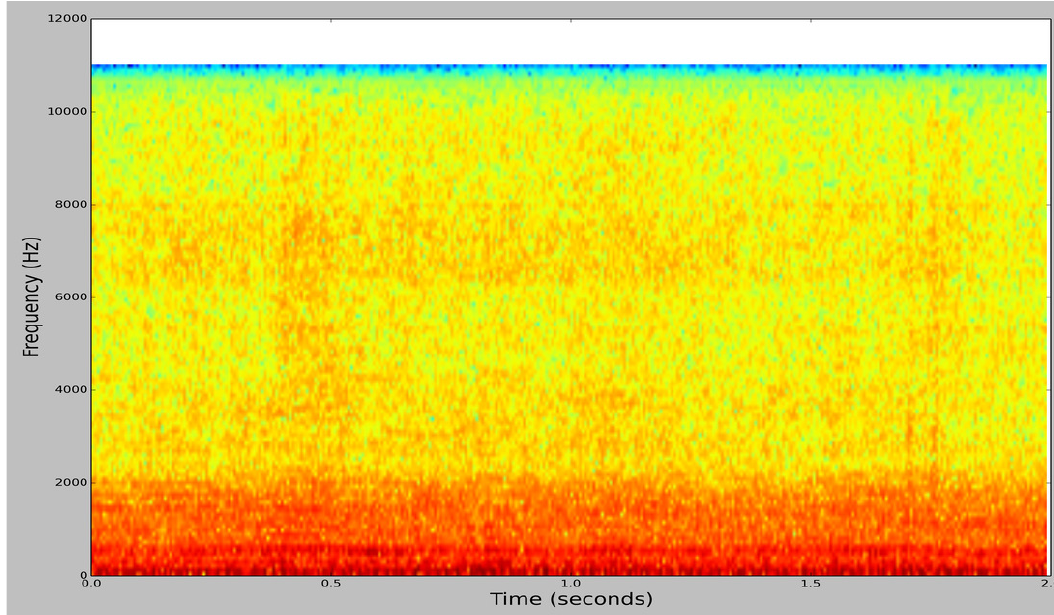
Figure 2. Spectrogram image of a bee buzzing audio sample from